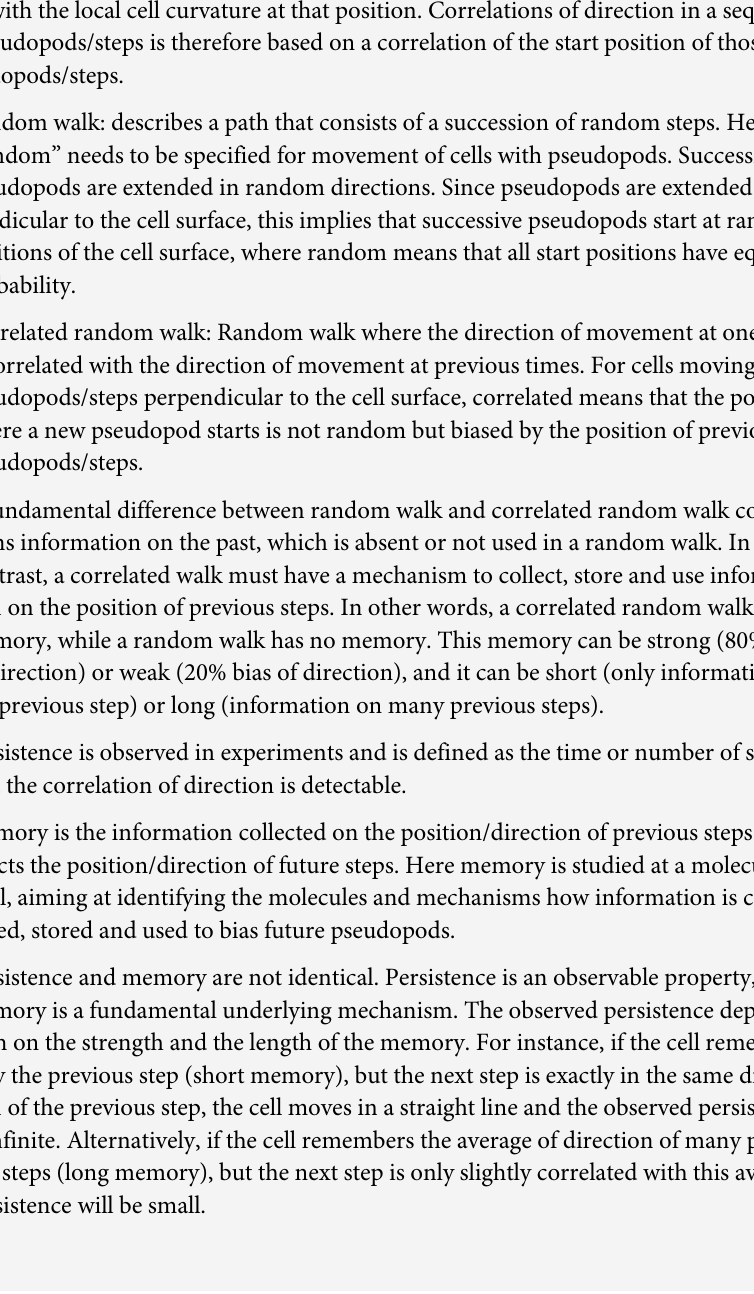
Box 1. Information box: Nomenclature, definitions and use of